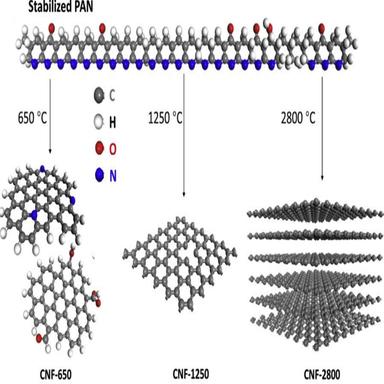
Correlation between the microstructure of CNFs and the annealing temperature. (A colour version of this figure can be viewed online.)